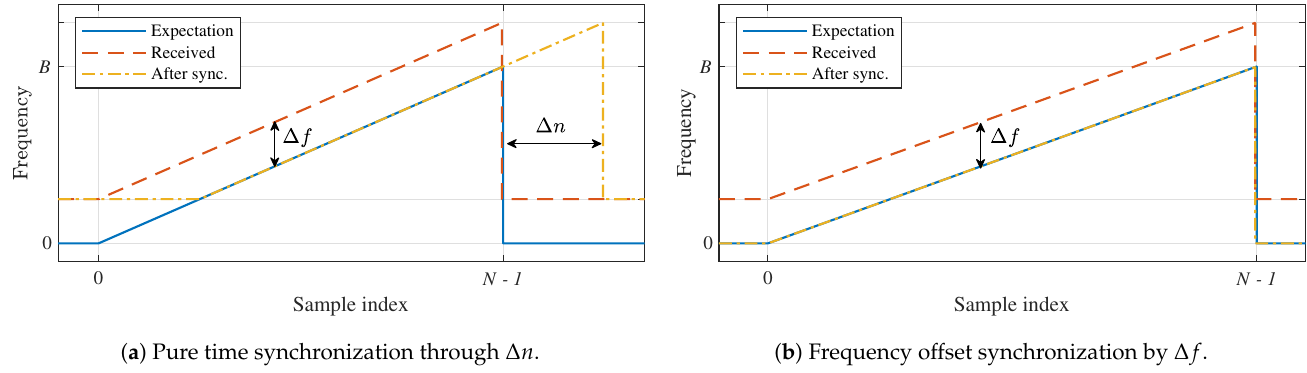
Figure 4. Up-chirps for time and frequency synchronization strategies that mitigate static Doppler shifts.